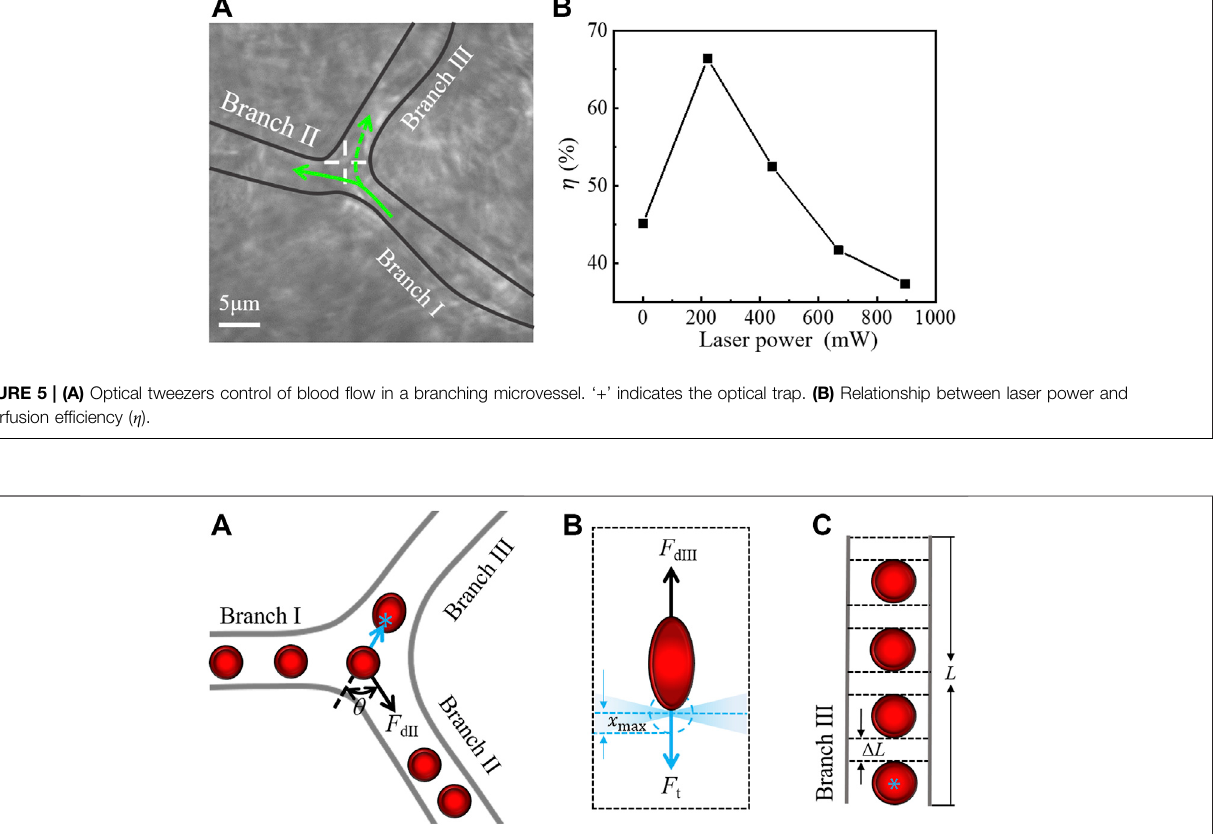
FIGURE6| Theoreticalanalysismodel. (A) RBCisredirectedand fl owstoBranch Ⅲ undertheactionofopticaltrap. ‘ * ’ indicatestheopticaltrap. (B) Forces onthe RBC being dragged by the blood fl ow. x max , the maximum action range of trapping force; (C) RBCs in Branch Ⅲ . F t , optical trapping force; F d Ⅱ and F d Ⅲ represents drag force from blood fl ow in Branch Ⅱ and Branch Ⅲ , respectively; and Δ L , increased length without RBC in the microvessel during the staying time t